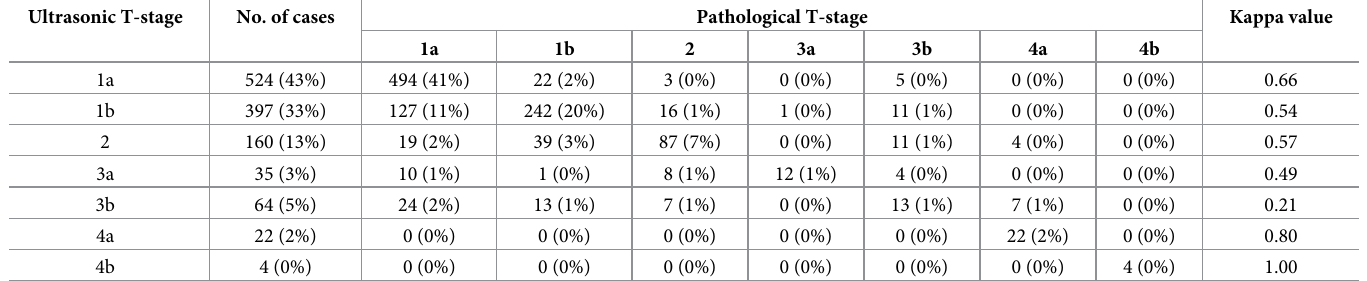
Table 4. The consistency between ultrasonic T-stages and pathological T-stages of DTC. Ultrasonic